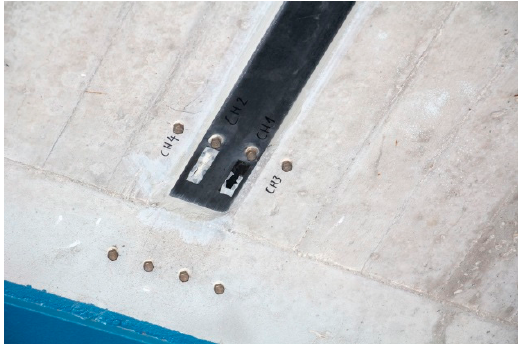
Figure 24. Measurement points at the end of a CFRP strip.